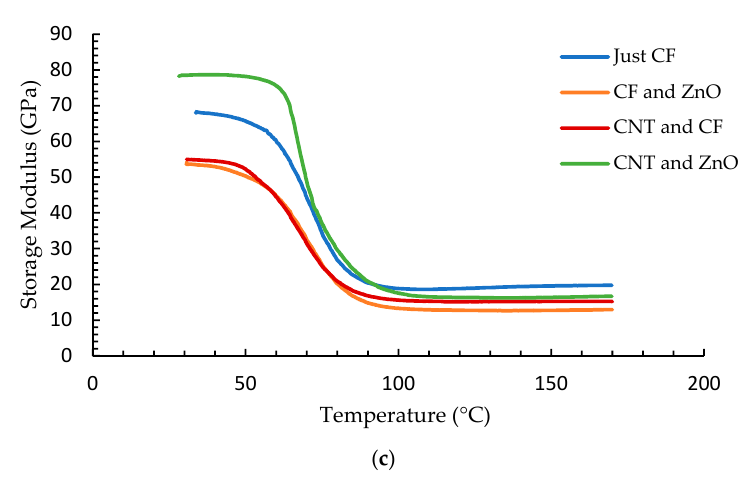
Figure 2. Evolution of the different composites’ viscoelastic properties in temperature sweep analysis at 1 Hz of various composites’ configurations. (a) Tan delta, (b) Loss modulus, and (c) Storage modulus.